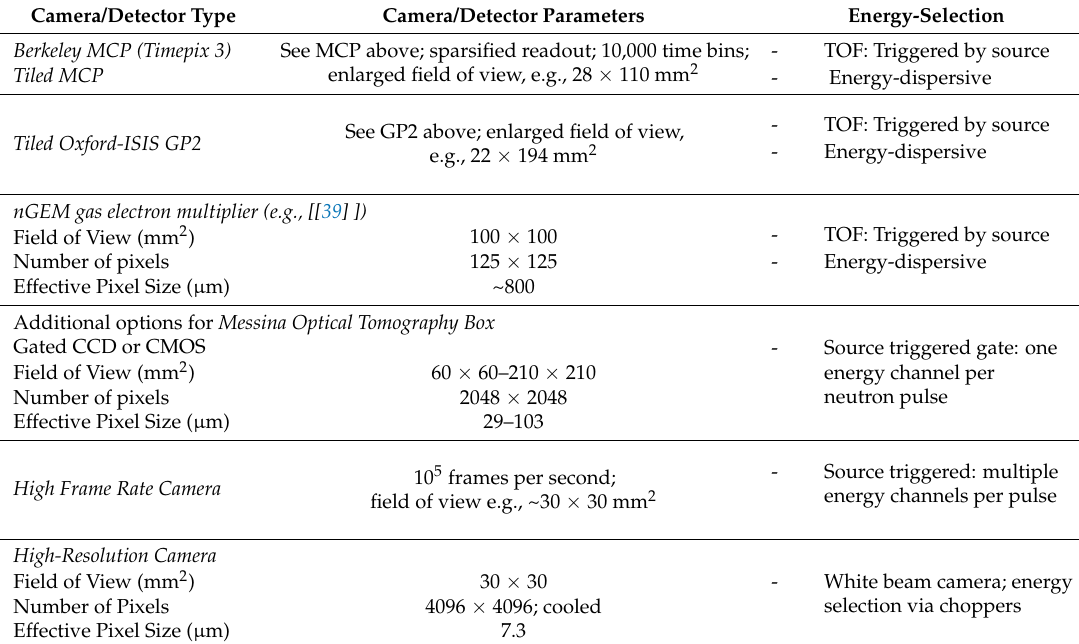
Table 2. Envisaged future IMAT camera